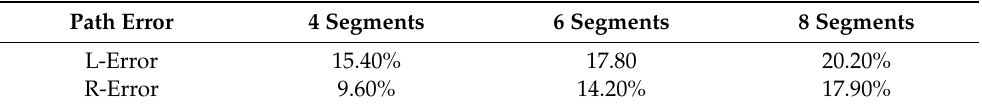
Figure 12. Robots with four, six, and eight segments pass through the same obstacles. The errors increase with the number of segments. The largest L-error and R-error for the four-segment robot ( a ) are 3.08 and 1.93. The largest L-error and R-error for the six-segment robot ( b ) are 3.56 and 2.84, and for the robot with eight segments ( c ), the largest L-error is 4.03, and the largest R-error is 3.58. The two insets show the robots ′ positions and gestures when they are at the L-error and R-error. ( a )i, ( b )i, and ( c )i are the waves with the maximum L-error. ( a )ii, ( b )ii, and ( c )ii are the waves with the maximum R-error. Table 1. The ratios of the errors normalized by the diameter of the robots with 4, 6, and 8 segments. The ratios increasing with the increasing number of segments.